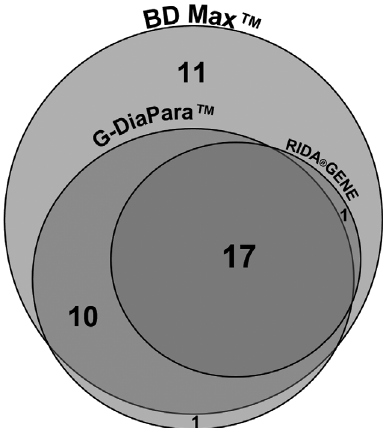
Figure 2. Venn diagram of results for Giardia detection. All Giardia -positive samples detected by the RIDA (cid:2) GENE assay were detected by the G-DiaPara TM and the BD Max TM assays, and almost all those detected by the G-DiaPara TM assay were detected by the BD Max TM assay (1 exception).